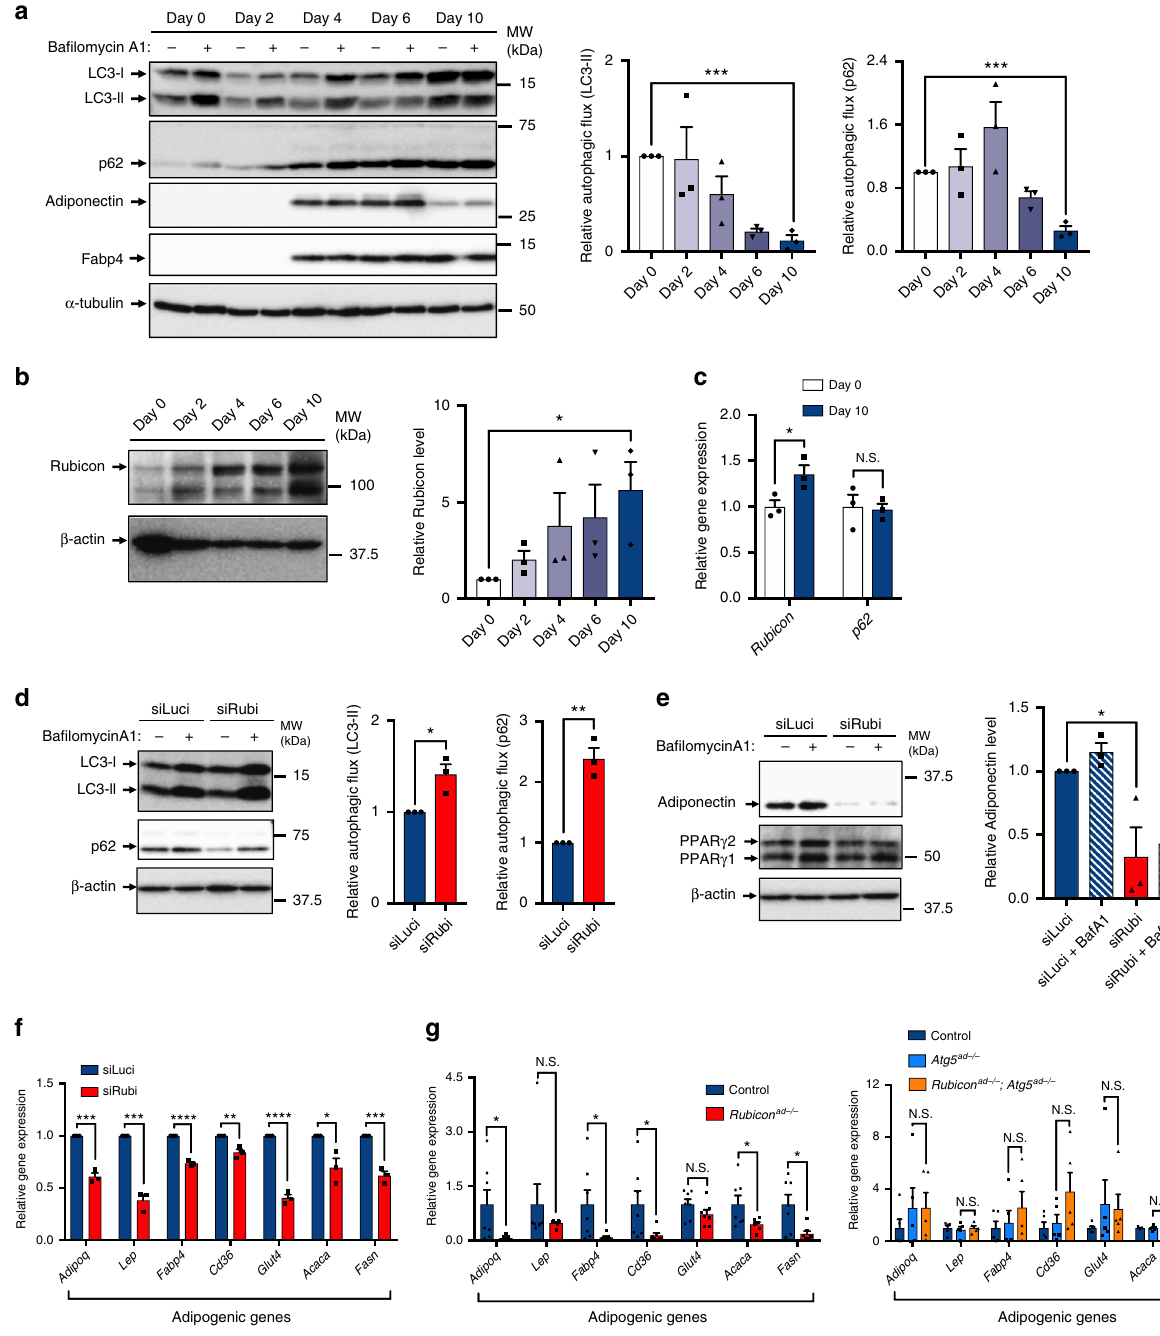
0.00.51.01.5 Fig. 4 Upregulation of Rubicon during adipogenesis ensures adipogenic gene expression. a Autophagic fl ux assay based on LC3-II and p62 degradation in 3T3-L1 cells on days 0, 2, 4, 6 and 10 following induction of differentiation. n = 3 independent experiments. b Immunoblotting to detect Rubicon in 3T3- L1 cells on days 0, 2, 4, 6 and 10 following induction of differentiation. n = 3 independent experiments. c Relative mRNA expression of Rubicon and p62 in 3T3-L1 cells on days 0 and 10 following induction of differentiation. n = 3. d Autophagic fl ux assay based on LC3-II and p62 degradation in Luciferase- or Rubicon -knockdown 3T3-L1 cells. Knockdown was carried out for 48 h starting on day 8 following induction of differentiation. n = 3 independent experiments. e Immunoblotting to detect adiponectin in Luciferase- or Rubicon -knockdown 3T3-L1 cells, treated with or without 125 nM Baf A1 for 2 h. Knockdown for 48 h was carried out on day 8 following induction of differentiation. n = 3 independent experiments. f Relative mRNA expression of adipogenic genes in Luciferase- or Rubicon -knockdown 3T3-L1 cells. Knockdown was carried out for 48 h starting on day 8 following induction of differentiation. n = 3 independent experiments. g Relative mRNA expression of adipogenic genes in eWAT depots of 21-week-old mice of the indicated genotypes on an NCD. n = 7 mice (left); n = 5 mice (right). Quanti fi cation data are shown in the graphs at the right of each blot. Error bars indicate means ± SEM. Data were analysed by two-tailed Student ’ s t test ( a – g ). P value from left to right: 0.0001, 0.0002 ( a ), 0.0335 ( b ), 0.0444, 0.8445 ( c ), 0.0210, 0.0016 ( d ), 0.0443 ( e ), 0.0004, 0.0004, <0.0001, 0.0070, <0.0001, 0.0271, 0.0008 ( f ), 0.0393, 0.3729, 0.0400, 0.0417, 0.1710, 0.0477,